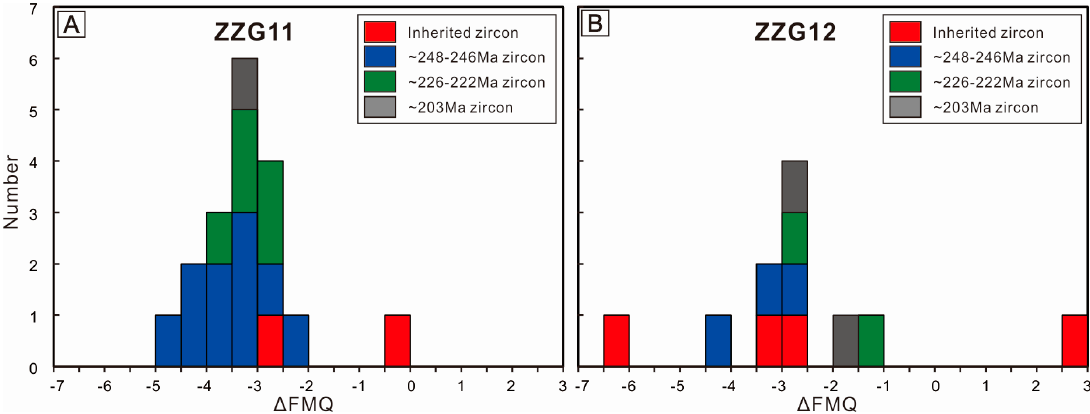
Figure 9. Magma oxygen fugacity for ZZG11 ( A ) and ZZG12 ( B ).